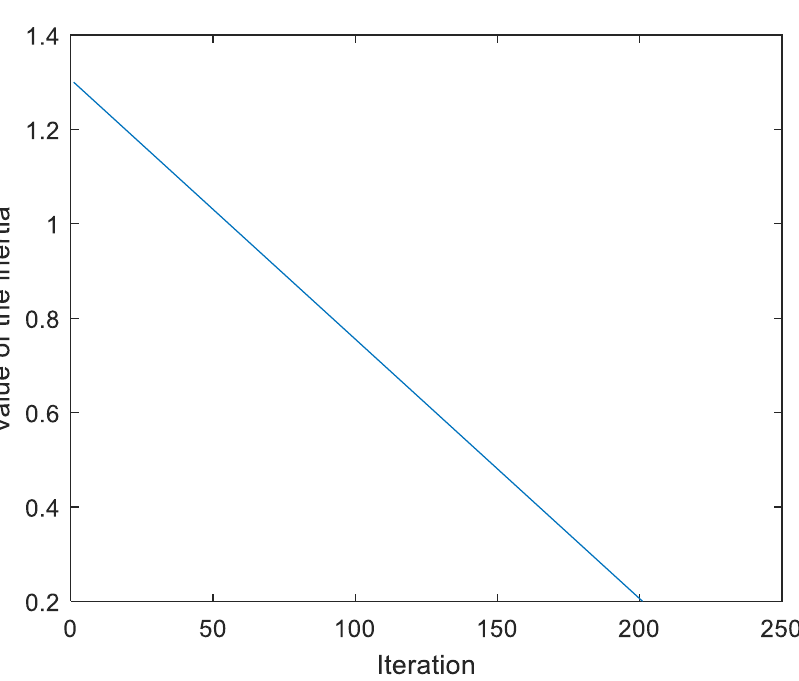
Figure 2. Weight changes through time (the inertia is a dimensionless parameter).